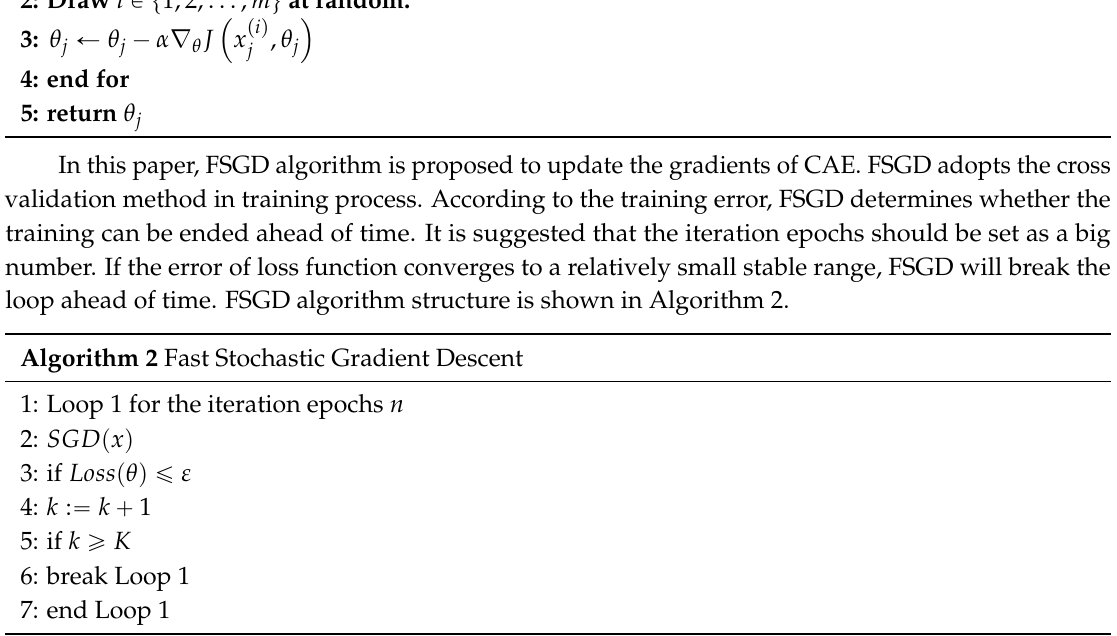
Algorithm 1 Stochastic Gradient Descent